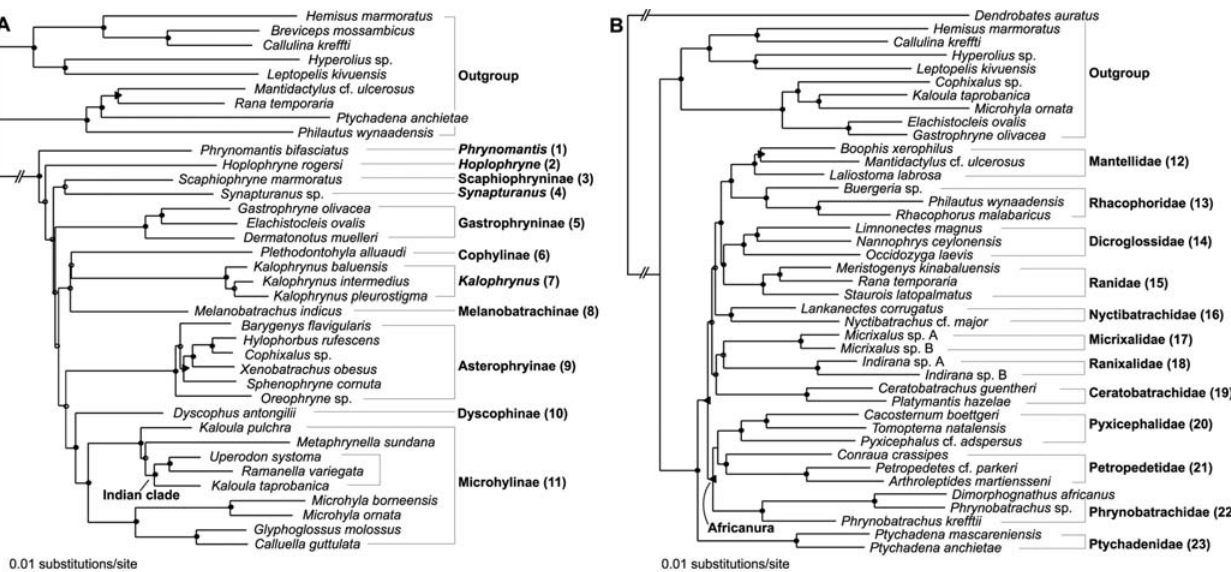
Figure 1. Maximum likelihood phylograms for ( A ) Microhylidae (-lnL=24126.41696) and ( B ) Natatanura (-lnL=53106.71363). Branch support is indicated as follows: black circles: ML bootstrap support (BS) $ 75% and Bayesian posterior probability (PP) $ 0.95; triangle pointing to the right: BS , 75%, PP $ 0.95; triangle pointing to the left: BS $ 75%, PP , 0.95; white circles: BS , 75% and PP , 0.95. Higher taxon names follow Frost et al. [13], with the exception of removal of Hoplophryne from Melanobatrachinae, and recognition of Ranixalidae.